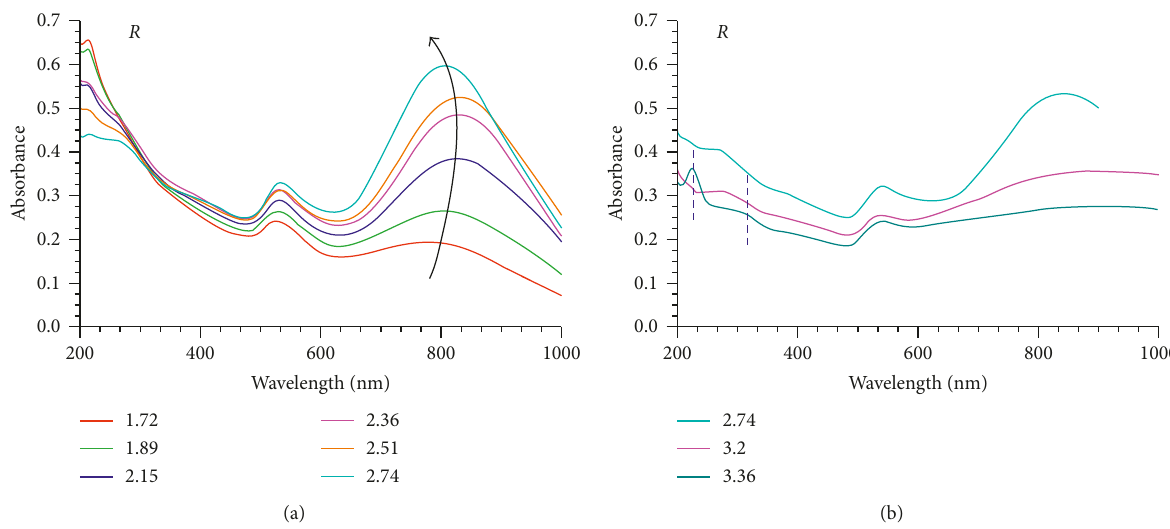
Figure 6: Evolution of the absorbance spectra of chitosan-capped NPs (CC-AuNPs) synthesized at different R values. (a) The stop-and- return behavior found for R ranging from 1.72 to 2.74. (b) Absorption bands for R ranging from 2.74 to 3.36.